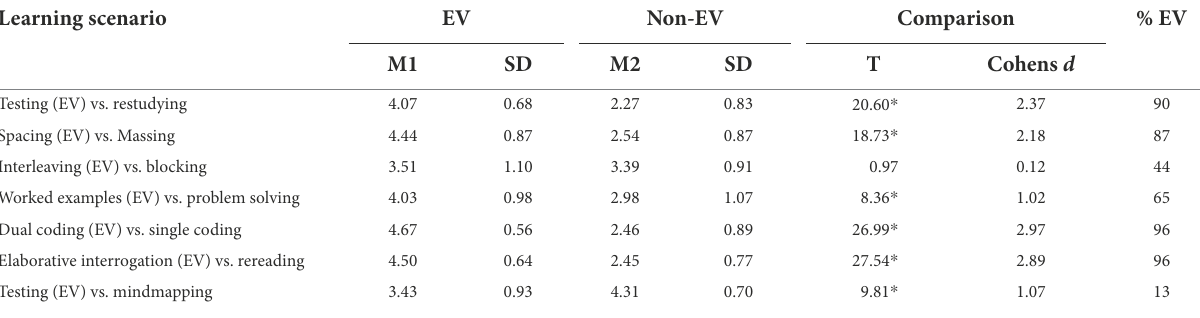
TABLE 5 Mean ratings (and standard deviations) for empirically validated learning strategies (EV) and non-empirically validated learning strategies (non-EV) for the learning scenario questions. Learning